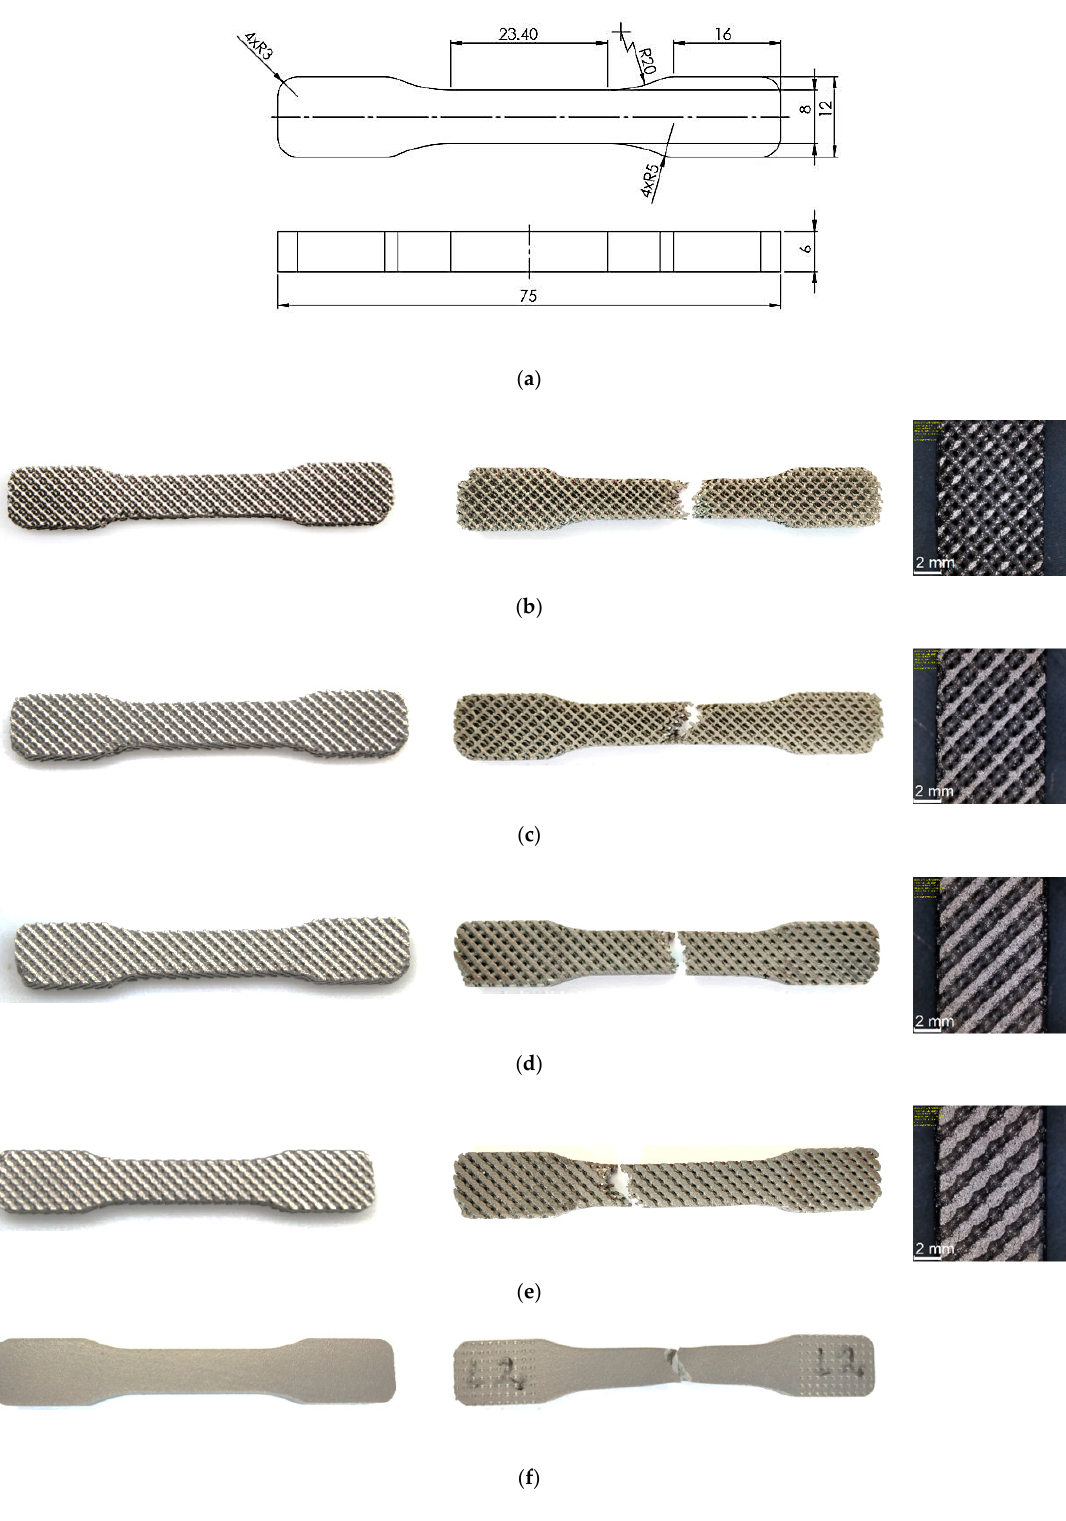
Figure 3. Spatial, tomographic and microtomographic images of the structure of samples of the Ti6Al4V titanium alloy with diamond structure and porosity: ( a ) 81%; ( b ) 73%; ( c ) 50%; ( d ) 34%.